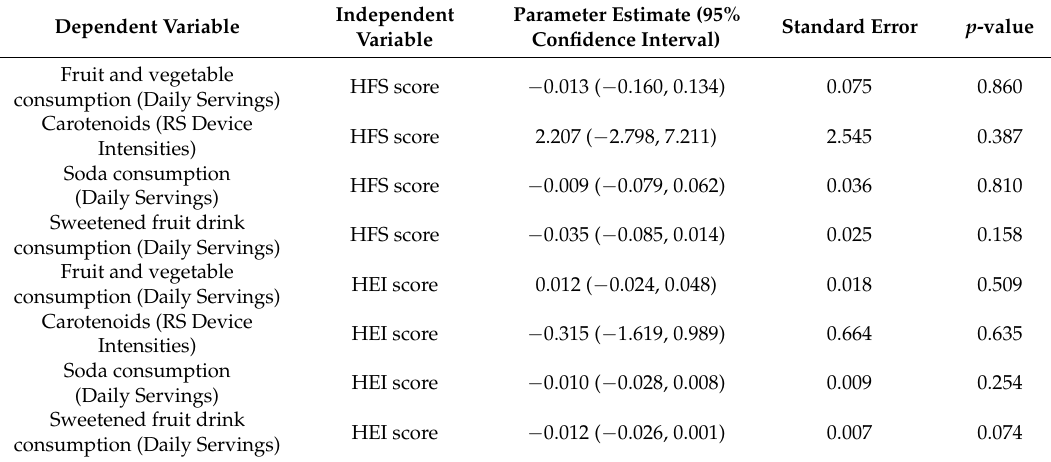
Table 4. Parameter estimates, standard errors, and p -values for associations between store-level Healthy Food Supply (HFS) Score, store-level Healthy Eating Index (HEI) score and individual-level self-reported and objectively-measured fruit and vegetable, soda, and sweetened fruit drink consumption., controlling for age, sex, and race. Independent Dependent Variable